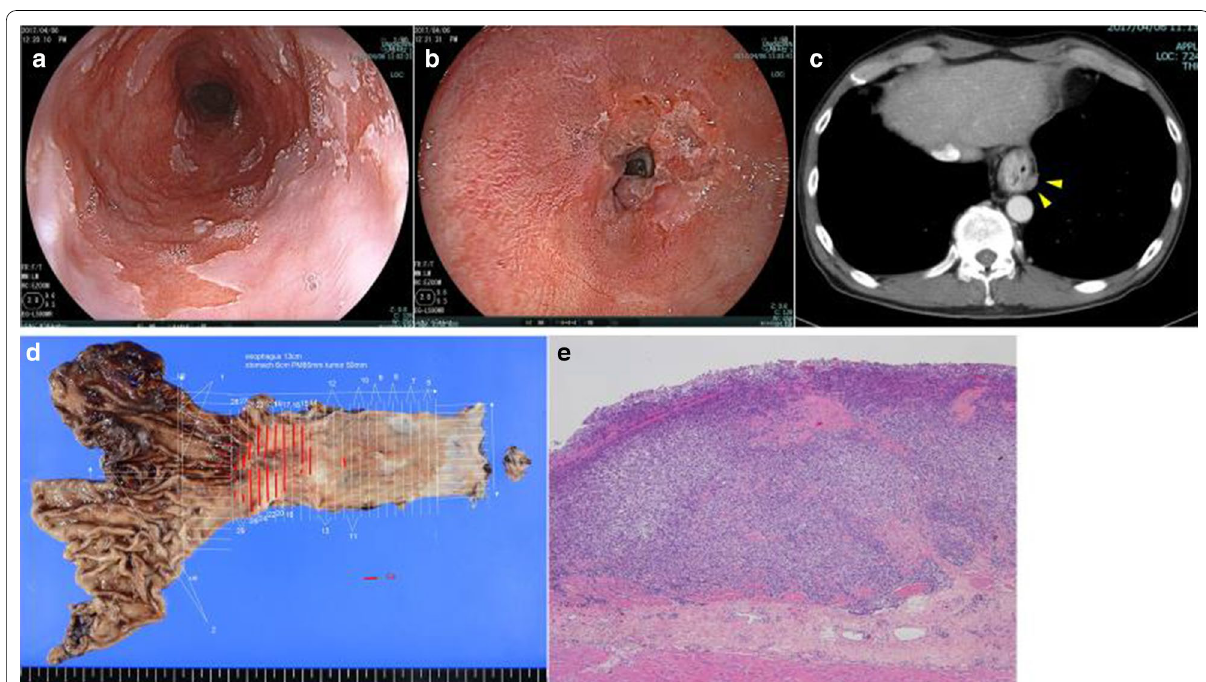
Fig. 1 Endoscopy, computed tomography, and histopathological findings for case 1. a , b Endoscopy revealed a squamocolumnar junction 24 cm from the incisor teeth and a type-3 circumferential tumor on the lower esophagus. c Computed tomography detected an enlarged lymph node (#110) but no other distant metastatic sites. d , e The postoperative pathological diagnosis was of poorly differentiated adenocarcinoma (T3 70 45 mm) with lymph node metastasis (pT3 pN3 pM0 pStage ×